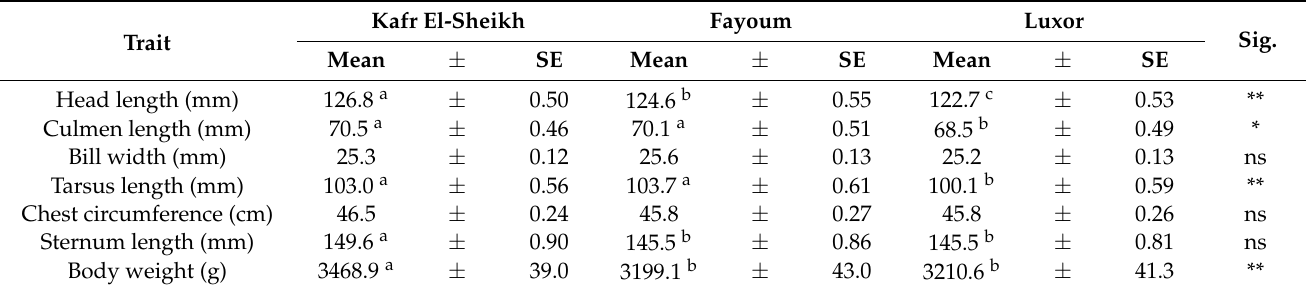
Table 2. Mean ± standard error (SE) of the body measurements in domestic Egyptian goose populations.